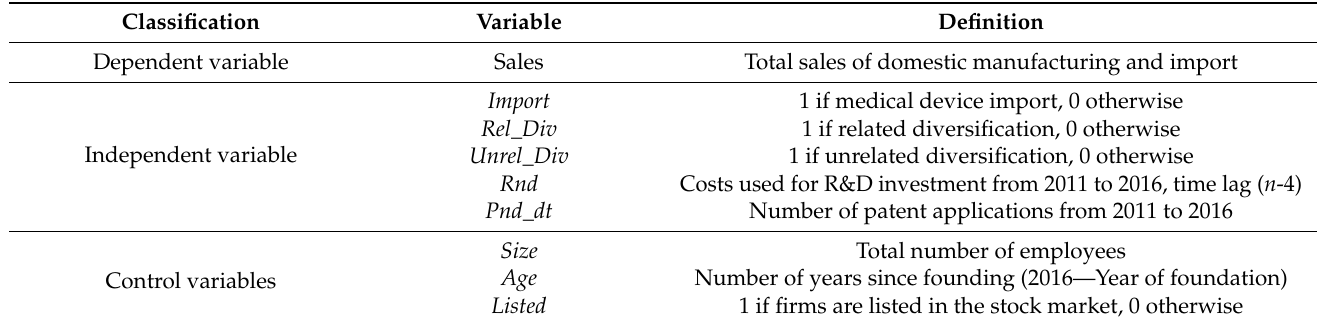
Table 3. Operational definition of variables.